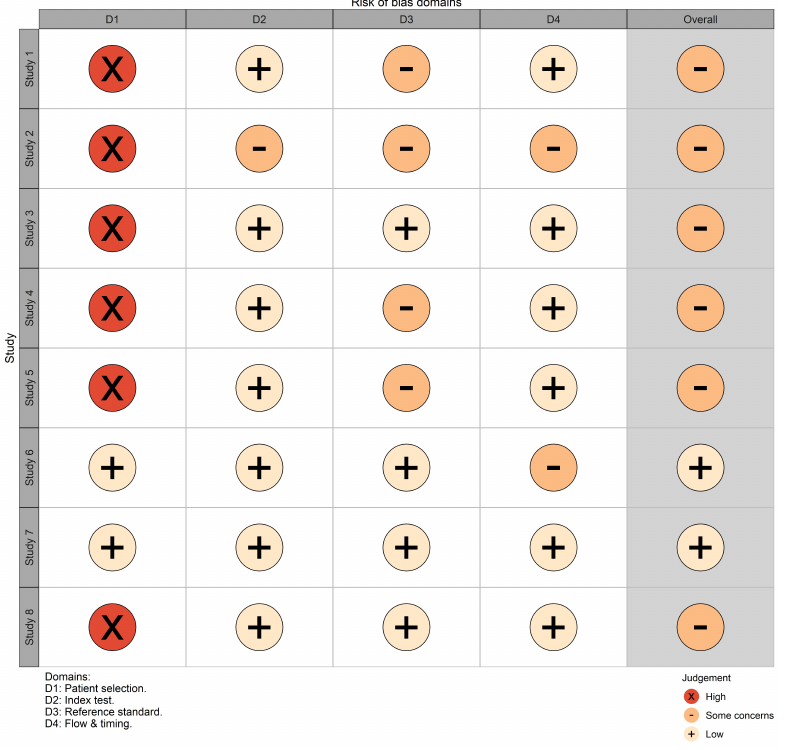
Figure 4. Risk of bias